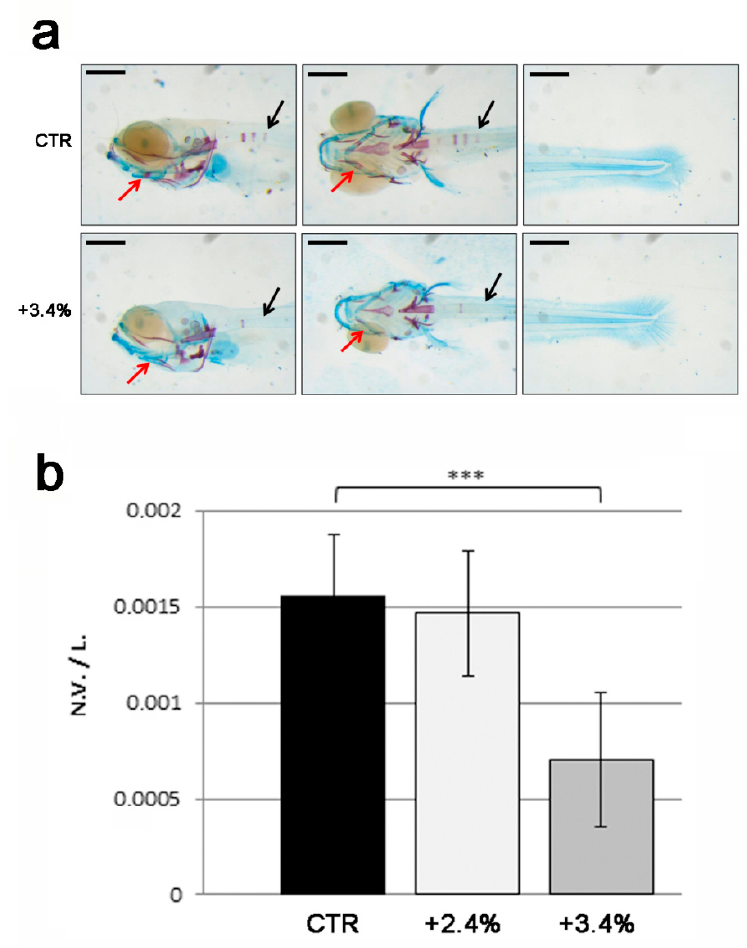
Figure 4. ( a ) Alcian Blue/ARS staining highlights a decreased number of mineralized vertebral bodies (black arrow) and a delayed chondrogenic mineralization of lower jawbone (red arrow) in +3.4% HP embryos. Scale bar: 200 µ m. ( b ) Vertebral mineralization rate of five days post fertilization embryos grown under different increased HP from 0% (CTR) up to 3.4%, evaluated as a ratio of the number of vertebral bodies positive for ARS staining along the length of the fish body (N.V./L.). Embryos grown under +3.4% HP showed a statistically significant variation in N.V./L. (CTR vs. +3.4%, *** p < 0.001, -54%).